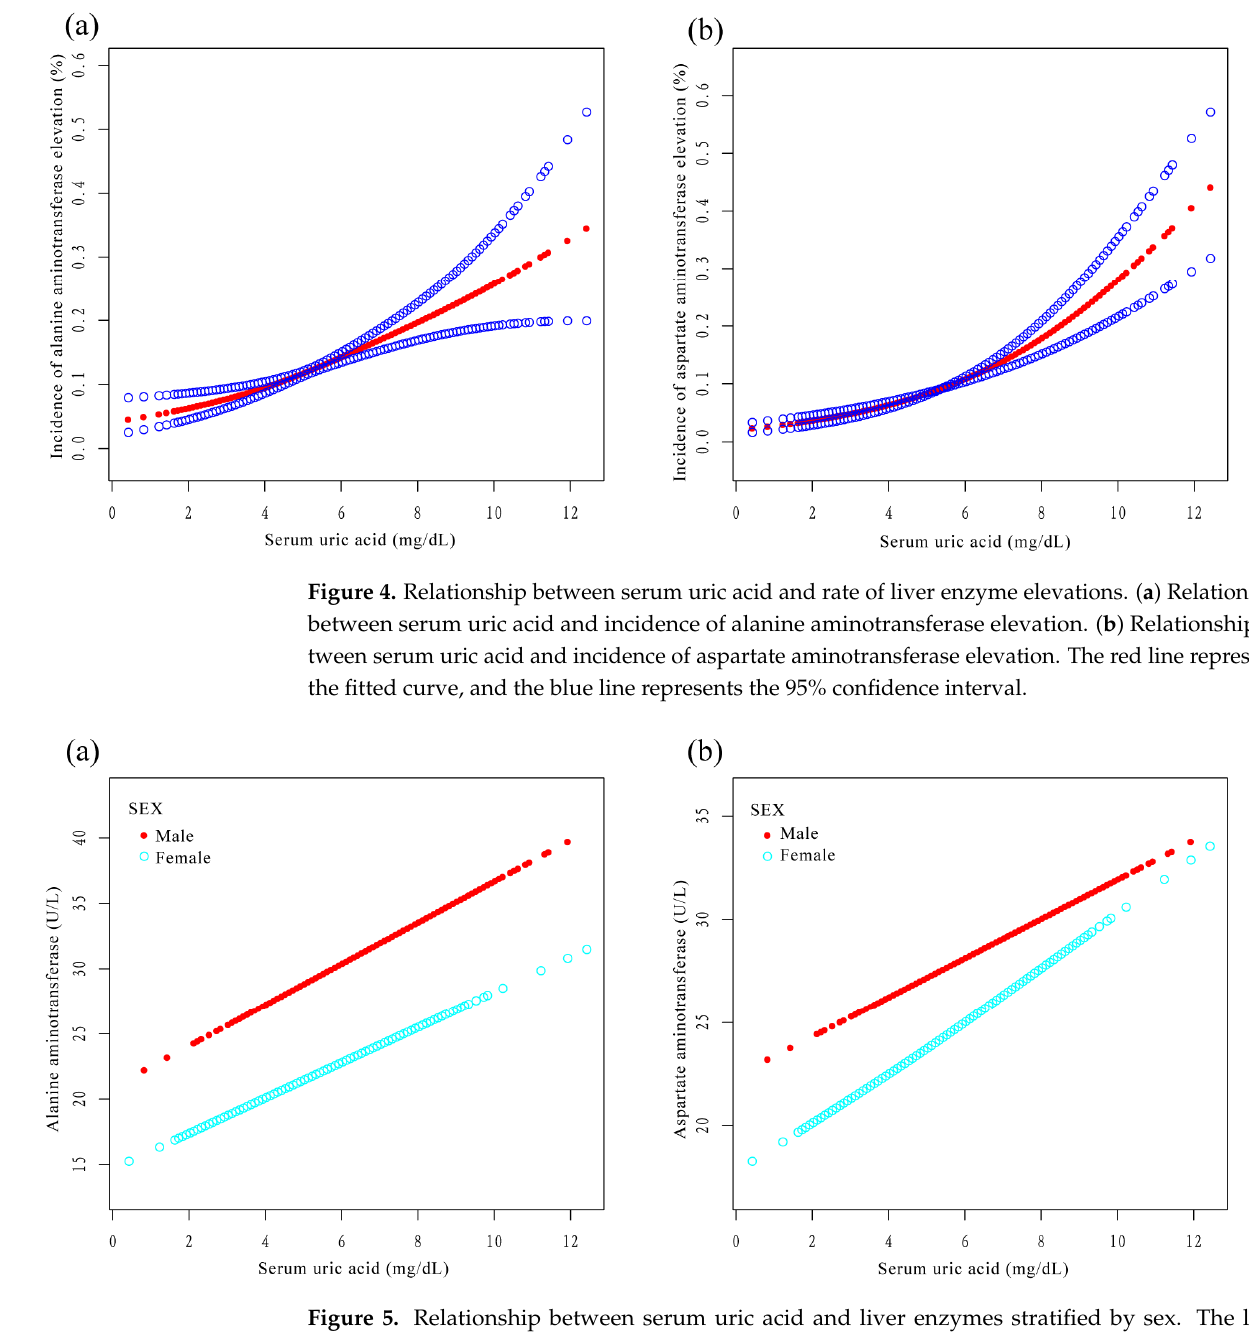
Figure 5. Relationship between serum uric acid and liver enzymes stratified by sex. The lines rep- resent fitted curves. ( a ) Relationship between serum uric acid and alanine aminotransferase strati- fied by sex (R 2 = 0.149). ( b ) Relationship between serum uric acid and aspartate aminotransferase stratified by sex (R 2 = 0.077).